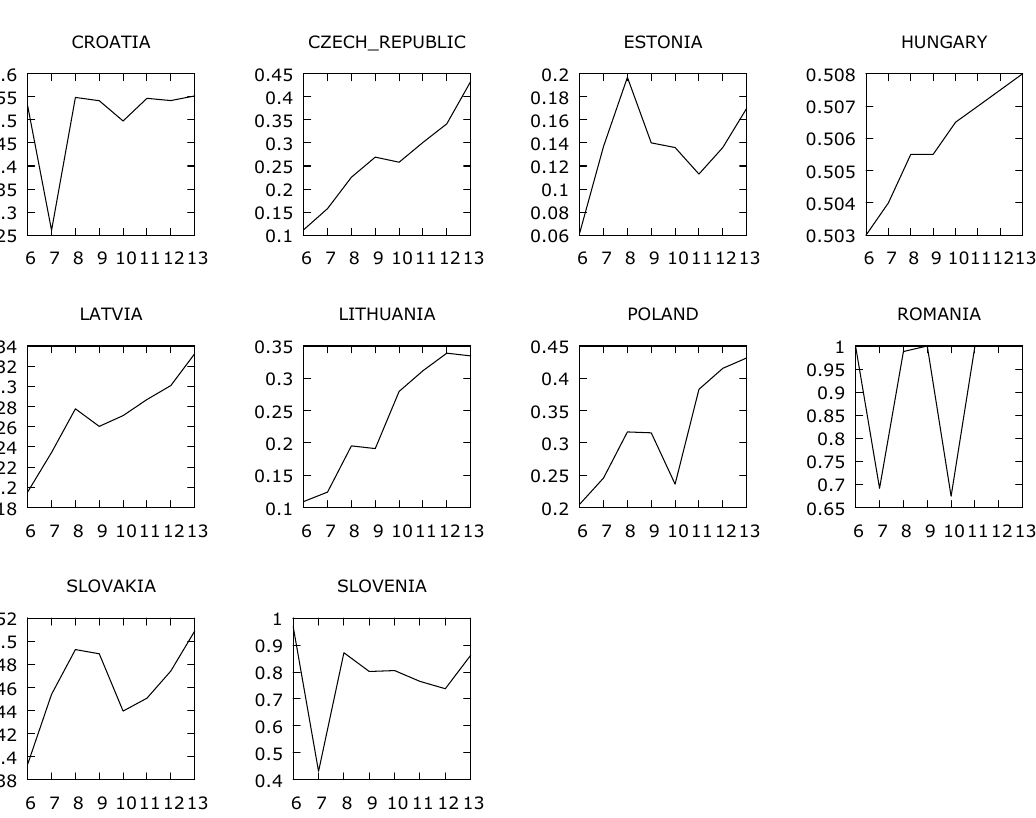
Figure 2. Average Efficiency1 banks in CEE countries. Source: Author’s own processing. The years on the x -axis are marked as follows: 2006 as “6”, 2007 as “7”, 2008 as “8”, 2009 as “9”, 2010 as “10”, 2011 as “11”, 2012 as “12” and the year 2013 as “13”.